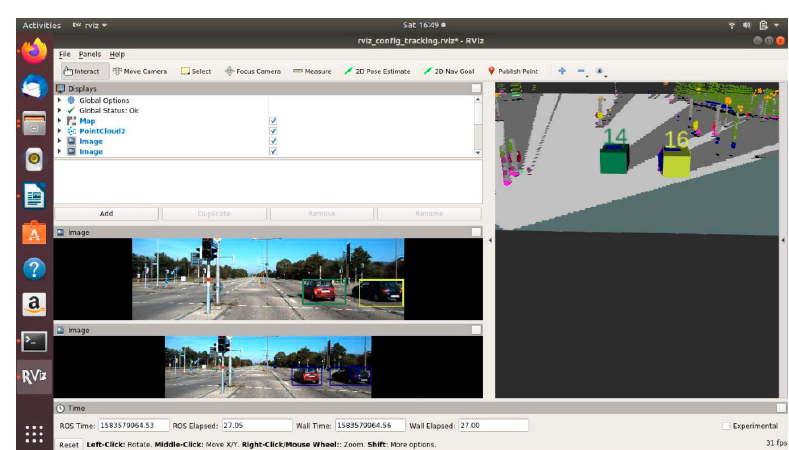
Figure 12. Output of sensor fusion in contrasting surroundings.